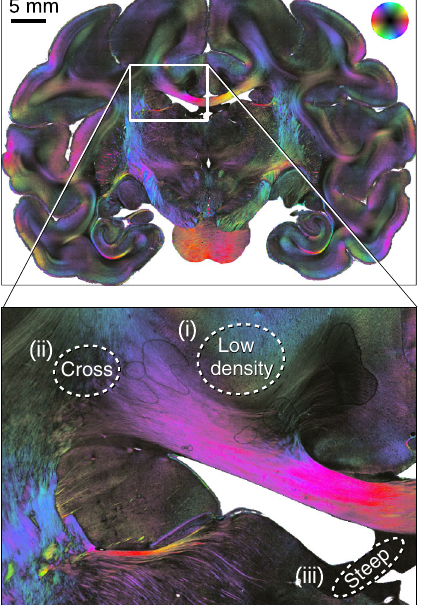
FIG. 1. Fiber orientation map of a coronal vervet monkey brain section, obtained from a 3D-PLI measurement with 1 . 33 μ m pixel size. The enlarged area highlights three brain regions that all yield low birefringence signals: (i) gray matter with low fiber density, (ii) crossing nerve fibers ( corona radiata ), and (iii) steep out-of-plane fibers ( fornix